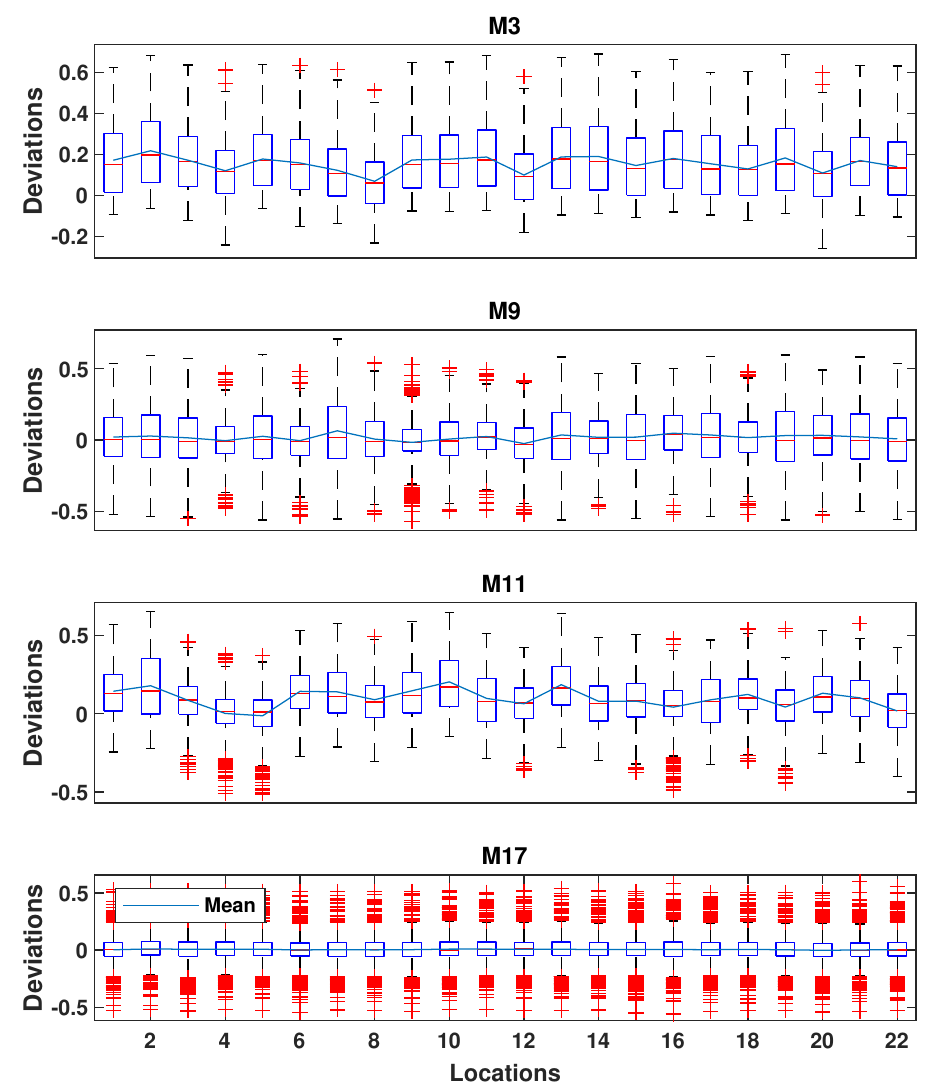
Figure 8. The absolute errors of the 22 locations at 15 min-timesteps